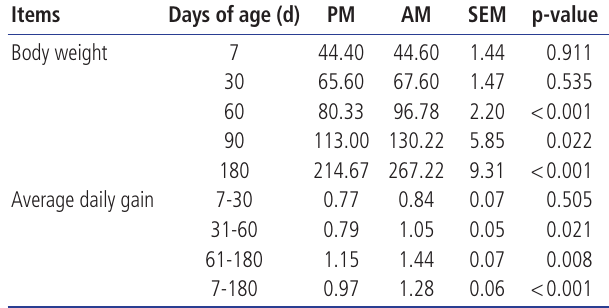
Table 1. The composition and bacteria count of the pasteurized and acidified milk Items PM